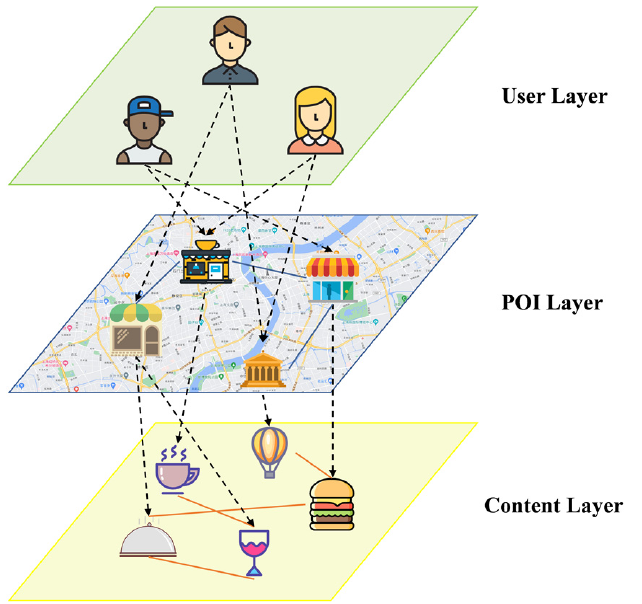
Figure 1. User record graph of POI recommendation scenarios. It contains three layers: user layer, POI layer and content layer, and the icons of each layer represent different nodes.